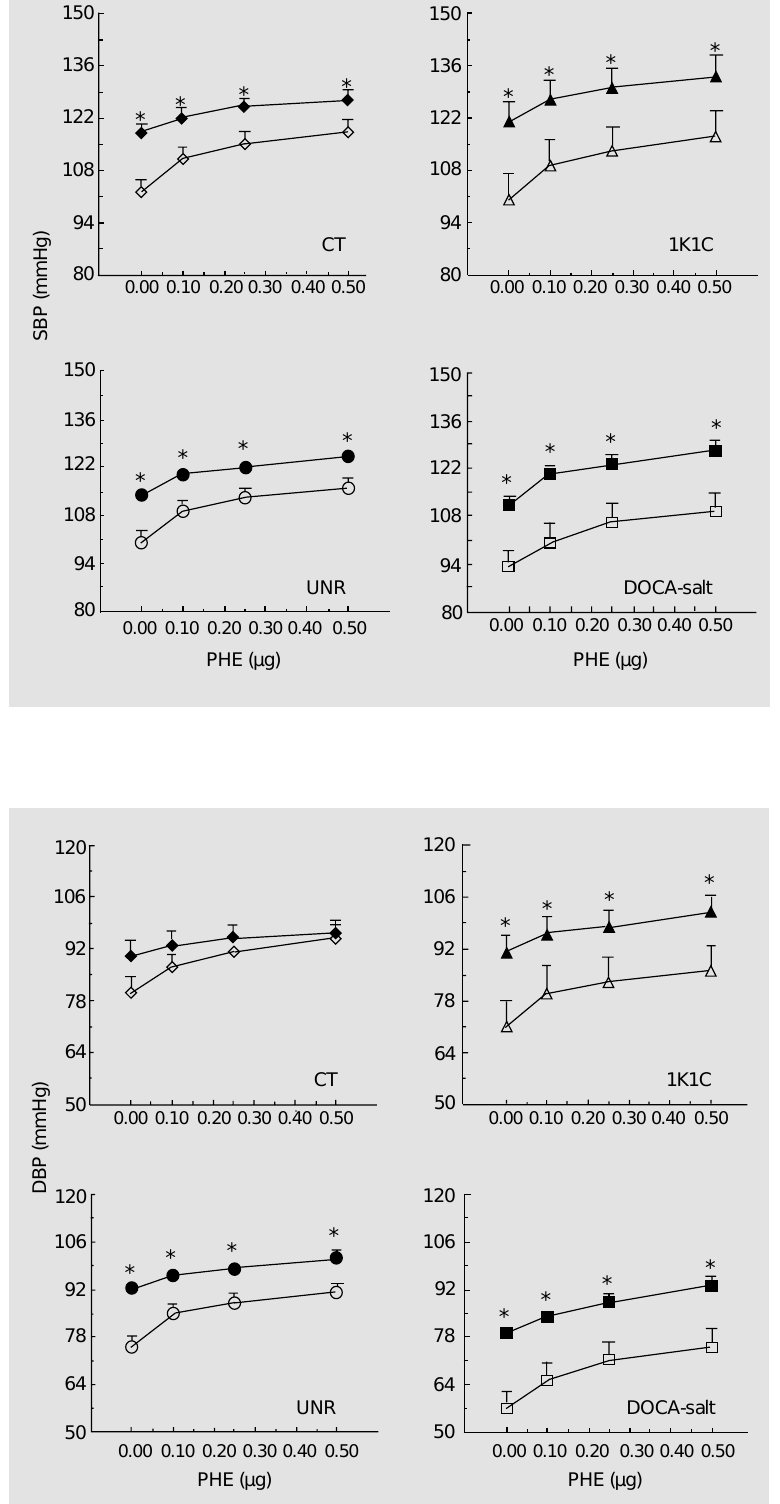
Figure 2. Changes in systolic blood pressure (SBP) in response to increasing doses of phenylephrine (PHE) in normotensive (control, CT; uninephrectomized, UNR) and hypertensive (1K1C and DOCA-salt) rats before (open symbols) and after (closed symbols) treatment with 18 µg/kg ouabain. Points represent the means ± SEM. *P<0.05 compared to before ouabain treatment (ANOVA).